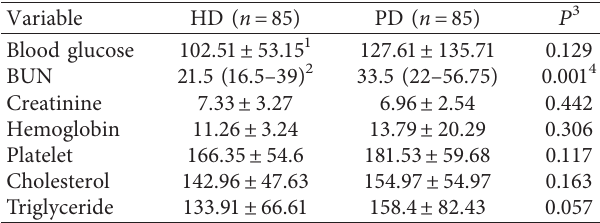
Table 2: Comparison of laboratory data between HD and PD groups.